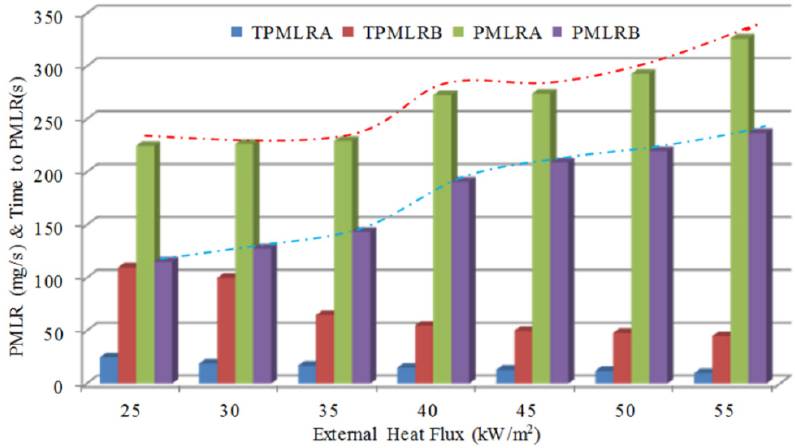
Figure 7. The maximum mass loss rate and the time to maximum with heat flux.